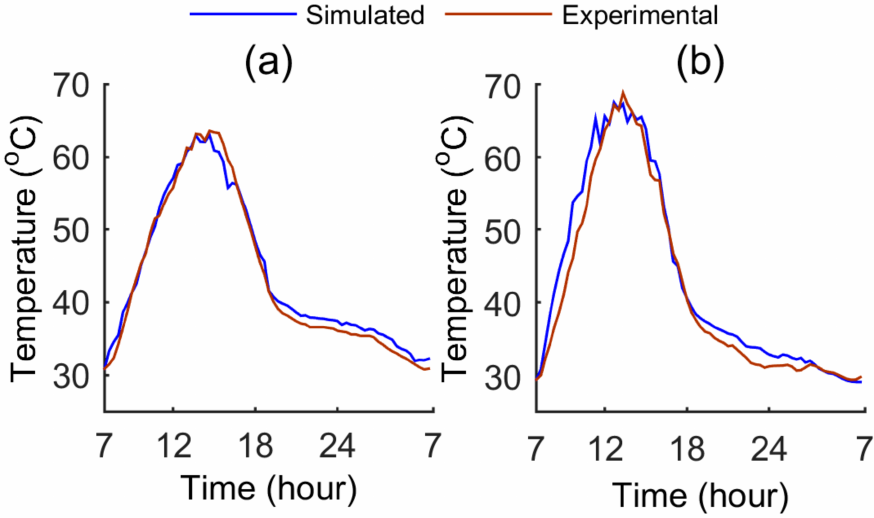
Figure 6. Validation of thermal output of the numerical